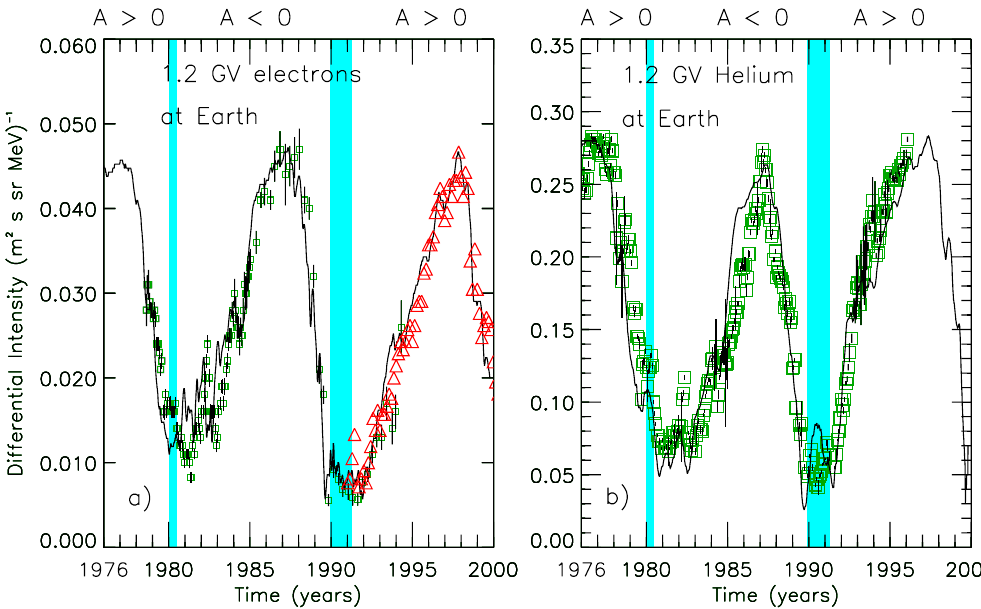
Fig. 2. (a) Computed 1.2GeV electron intensity at Earth compared to observations from ISEE3/ICE (e.g. Clem et al., 1996; Evenson, 1998) and Ulysses (e.g. Heber et al., 2002; Clem et al., 2002). (b) Computed 1.2GV Helium intensity at Earth compared to observations from IMP (McDonald, 1998; McDonald et al.,